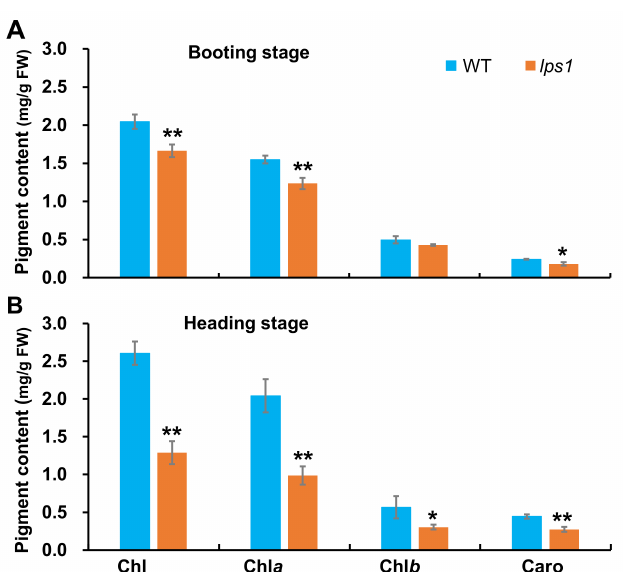
Figure 3. Pigment contents in leaves of WT and lps1 . ( A ) The top leaf at booting stage. ( B ) The flag leaf at heading stage. Error bars represent standard deviations of three independent biological replicates. The statistically significant differences were performed by Student’s t test. * p < 0.05 and ** p <